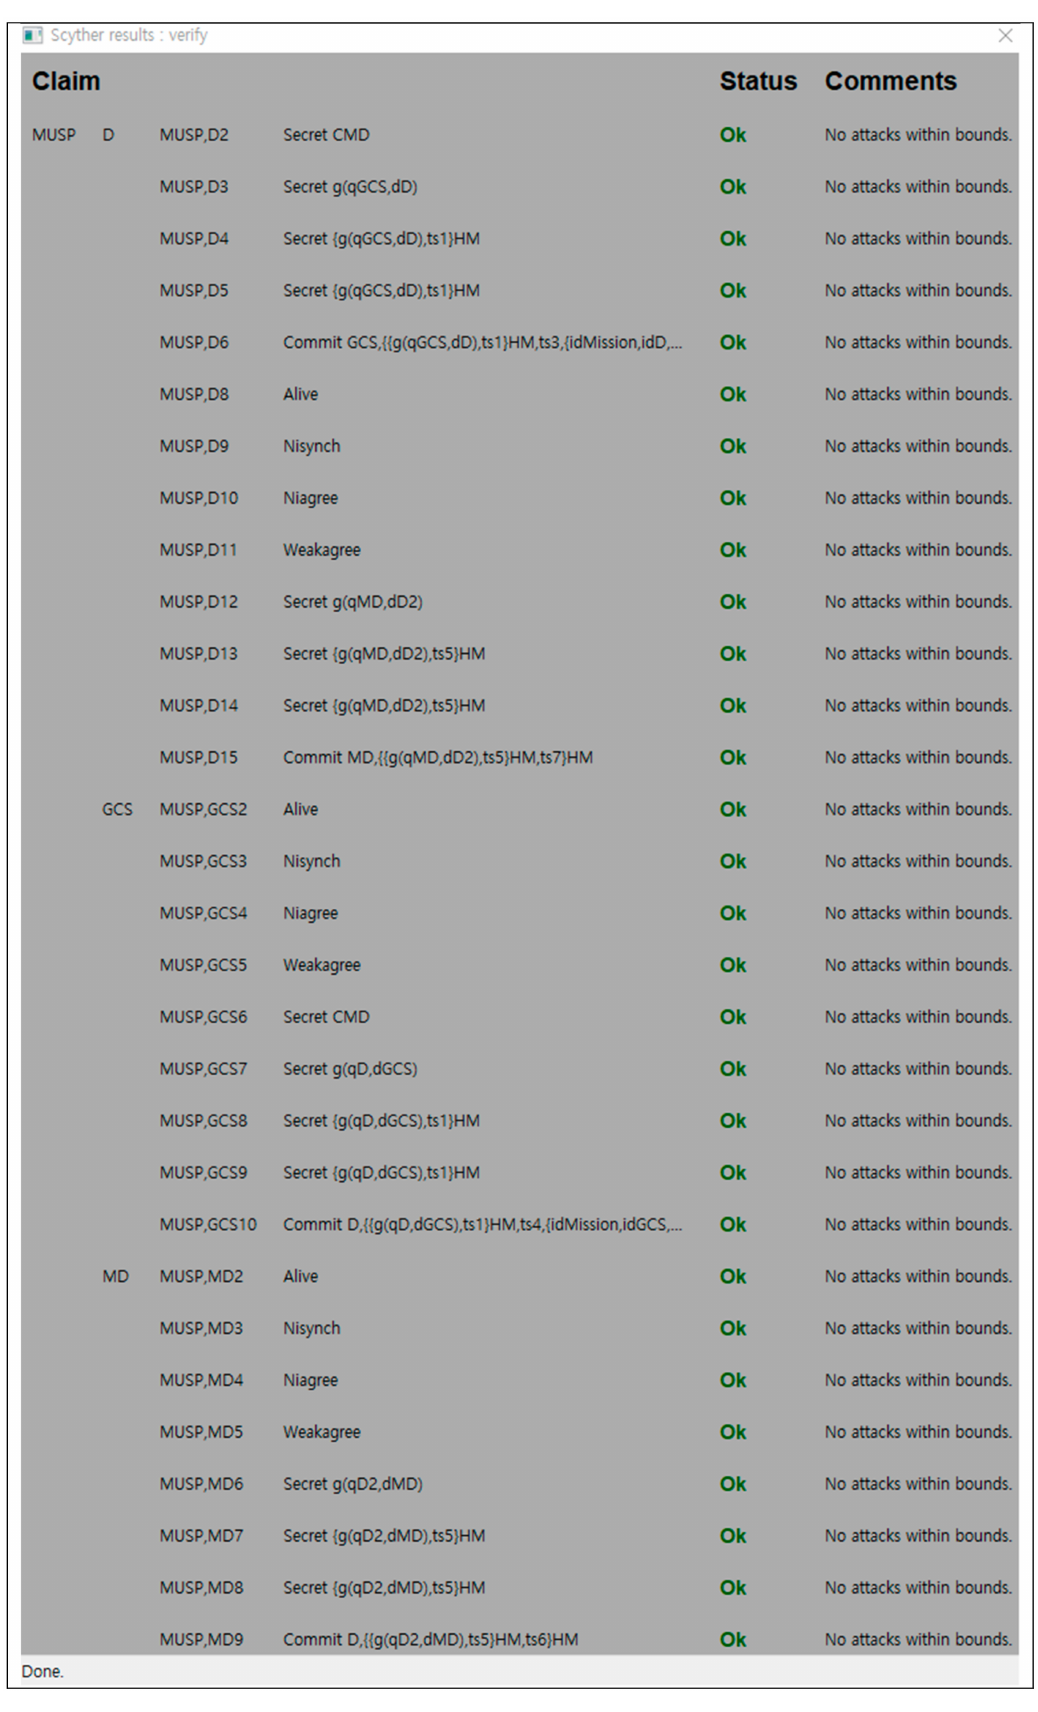
Figure 7. A Scyther verification